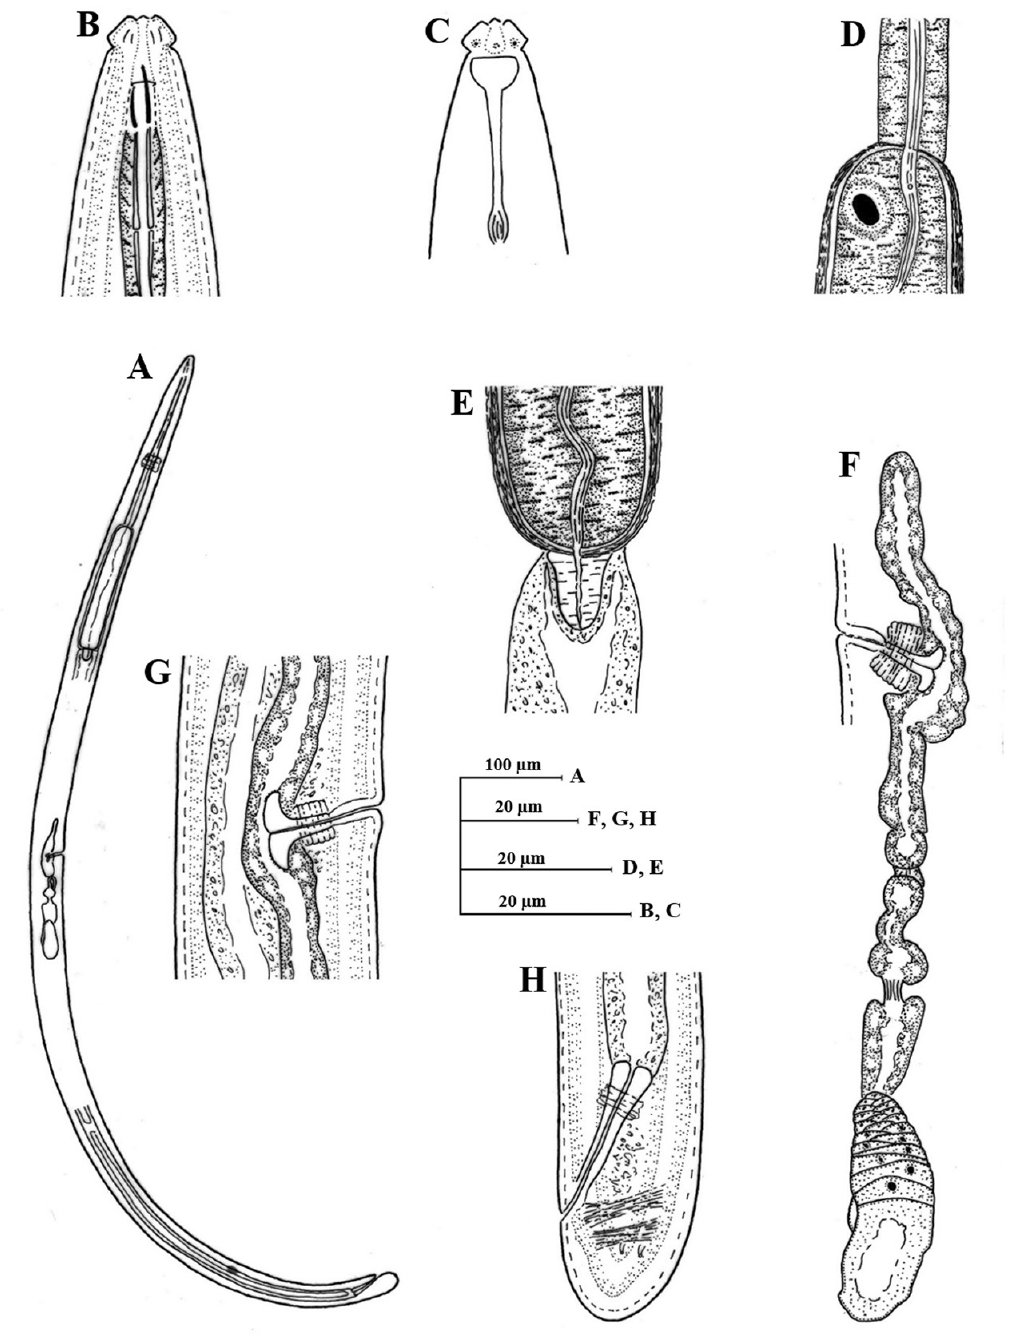
Fig. 5. Axonchium indicum sp. nov. A – C . Paratype 2, ♀ (slide 2). D – H . Paratype 6, ♀ (slide 4). A . Entire body. B . Anterior region. C . Anterior end showing amphid. D . Junction between anterior slender and posterior expanded part of pharynx. E . Cardia. F . Female genital system. G . Vulva. H . Female posterior